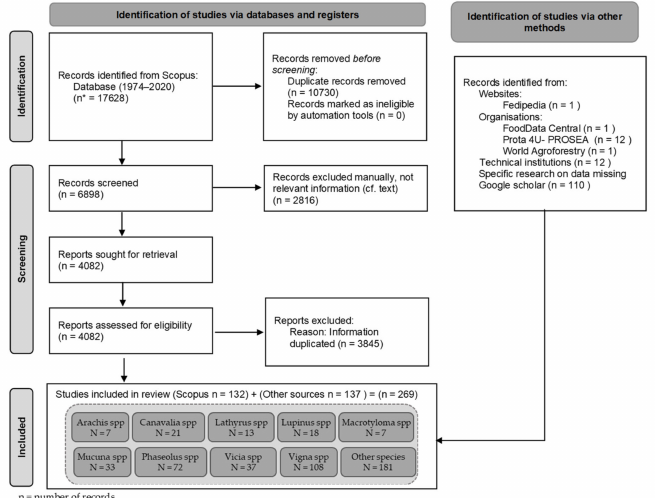
Figure 1. PRISMA 2020 flow diagram systematic review on pulses [41]. Details on the species included as well as on the number of papers retrieved are provided in Table